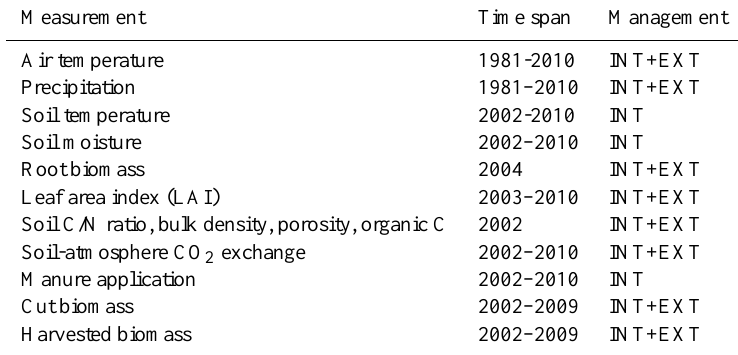
Table 2. Measurements taken in the context of the Oensingen experiments, used in this study (Ammann et al., 2007, 2009).